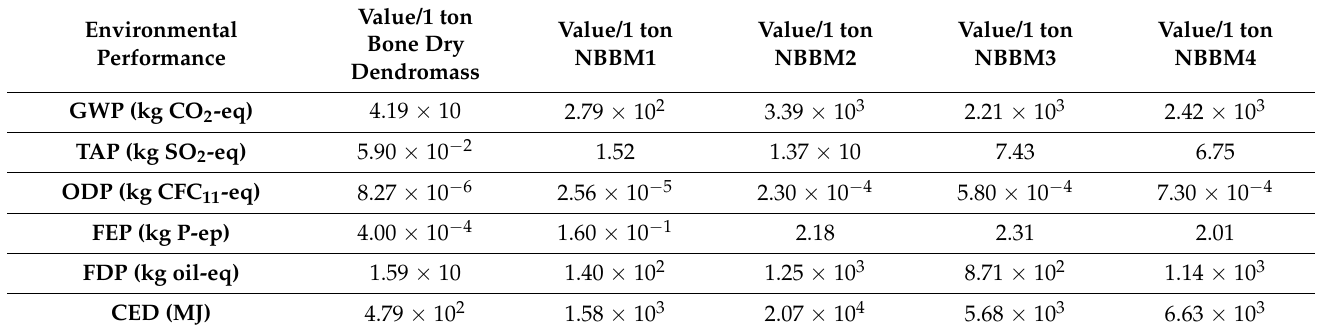
Table 2. Environmental performance of the dendromass production and NBBM1–4 per ton of